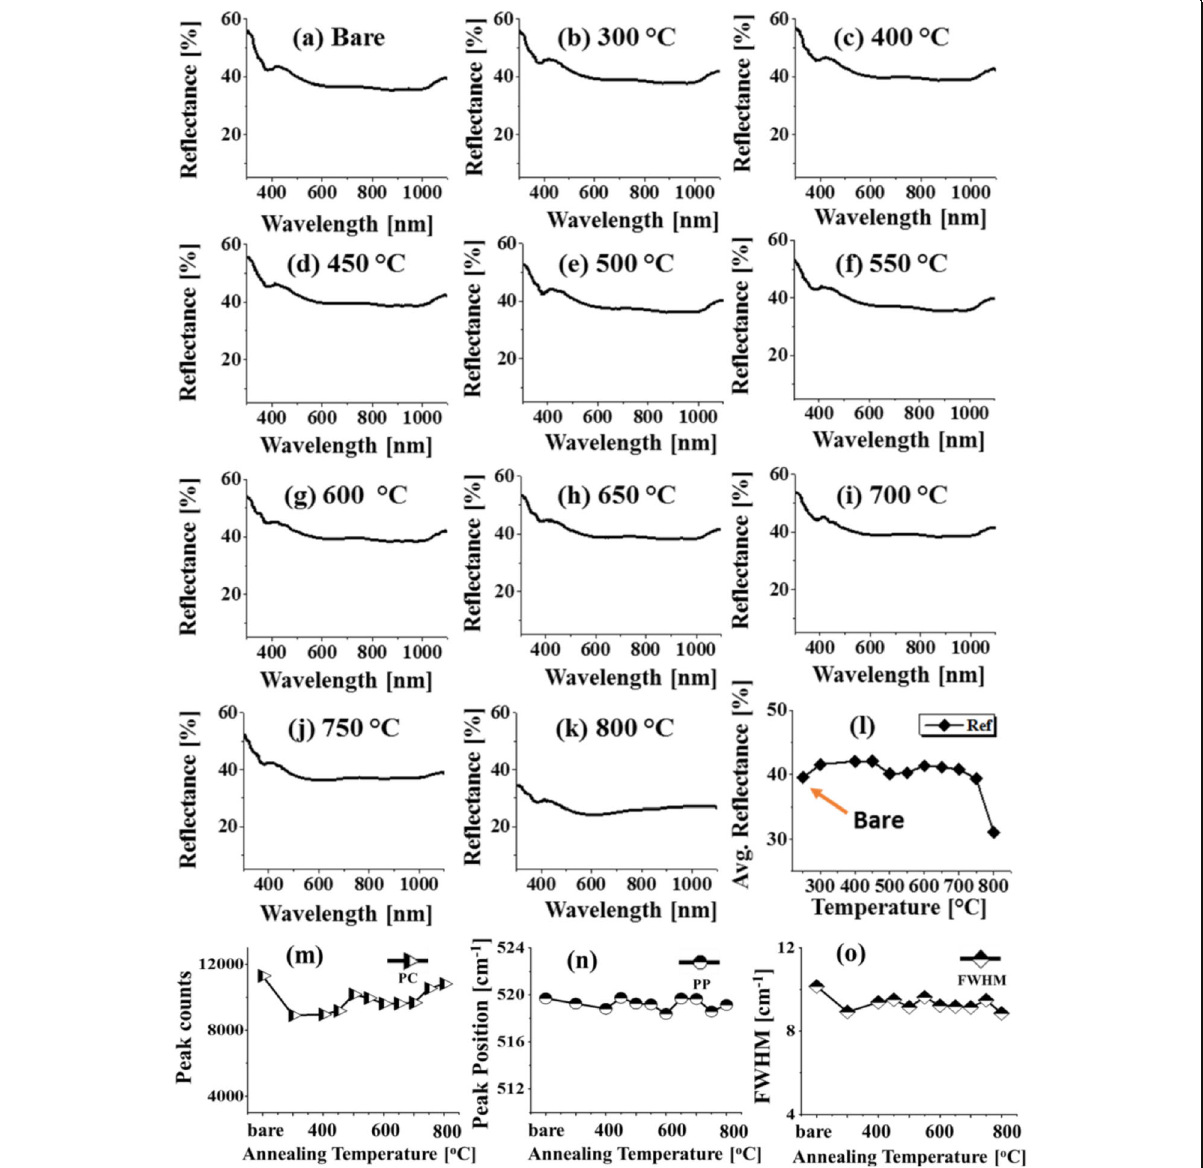
Fig. 8 Reflectance spectra of the Pd nanostructures on Si (111) fabricated at varying temperatures. a – k Bare Si (111) and samples annealed at 300 – 800 °C for 450 s with 5 nm of Pd deposition amount. l Summary plot of average reflectance. m – o Summary plots of PC , PP , and FWHM of the Raman spectra as a function of the annealing